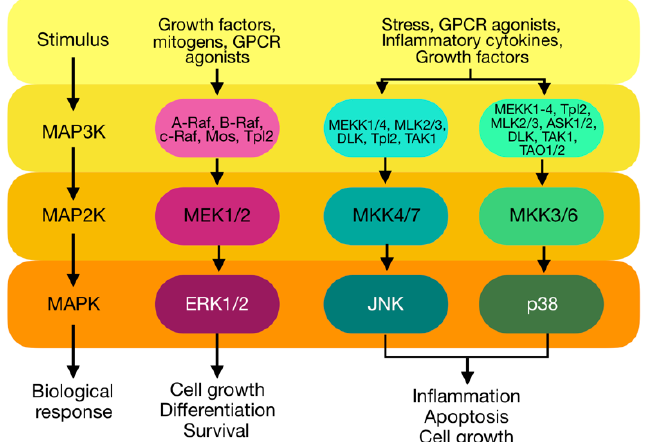
Figure 3. MAPKs cascades: MAPK signalling cascades are organized hierarchically into three-tiered modules. MAPKs are phosphorylated and activated by MAPK-kinases (MAP2Ks), which in turn are phosphorylated and activated by MAPKK-kinases (MAP3Ks). The MAP3Ks are in turn activated by interaction with the family of small GTPases and/or other protein kinases, connecting the MAPK module to cell surface receptors or external stimuli.